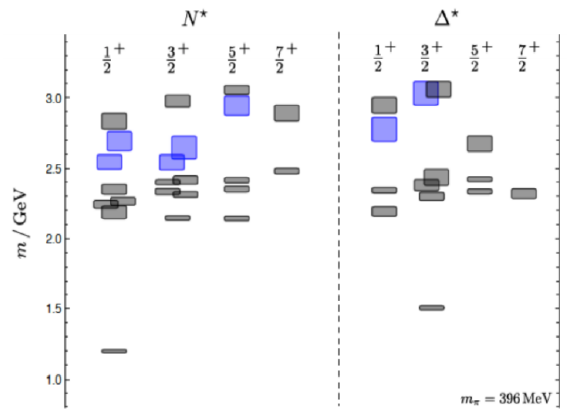
Figure 1. The light-quark baryon spectrum predicted in Lattice QCD at a pion mass of 396 MeV [1]. Grey boxes are con- ventional qqq states and the blue shaded boxes indicate hybrid baryons states. Note that both the mass of the nucleon ground state and of the ∆ (1232) are shifted by nearly 300 MeV to higher masses.